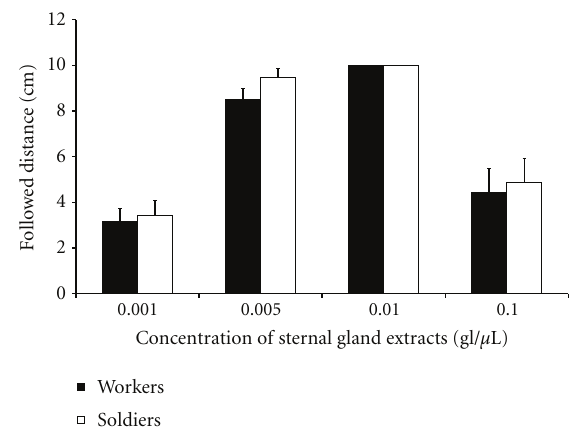
Figure 4: Termite activity elicited by sternal gland extracts of Coptotermes gestroi . Values indicate mean followed distance ( ± SD) by workers and soldiers. N =